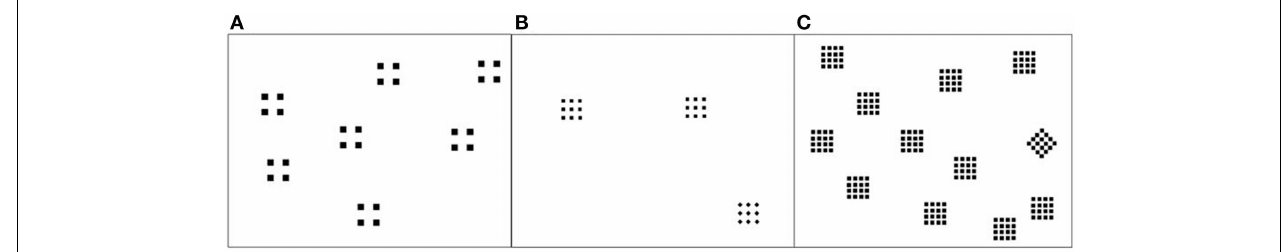
FIGURE 1 | Example trials in Experiment 1, showing different number of elements per item, and different numbers of items. (A) target-absent trial. (B) element-different trial. (C) configuration-different trial.